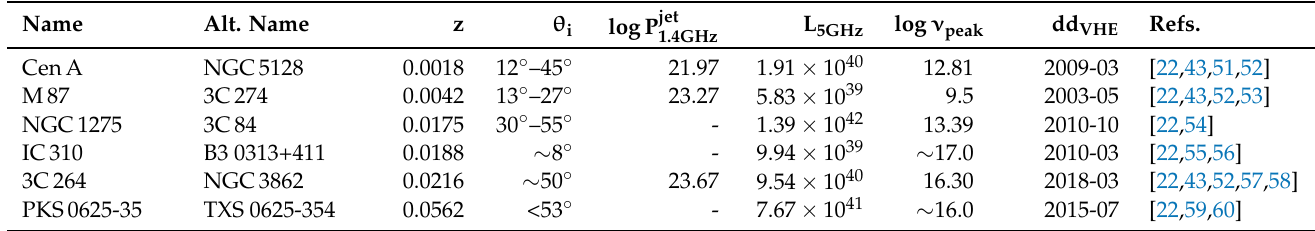
Table 3. Highlighted here are the key characteristics of the 6 non-blazar AGNs detected at TeV energies. The table is sorted by redshift in ascending order. The column details are as follows: the common name given to the AGN (Name), an alternative name for the AGN (Alt. Name), redshift (z), the jet inclination angle to the line-of-sight ( θ i (degrees)), jet power (P jet luminosity at 5 GHz (L 5GHz (ergs/s)), synchrotron peak frequency ( ν peak (Hz)), VHE discovery date (dd VHE (year-month)), and finally, a column containing references for each object